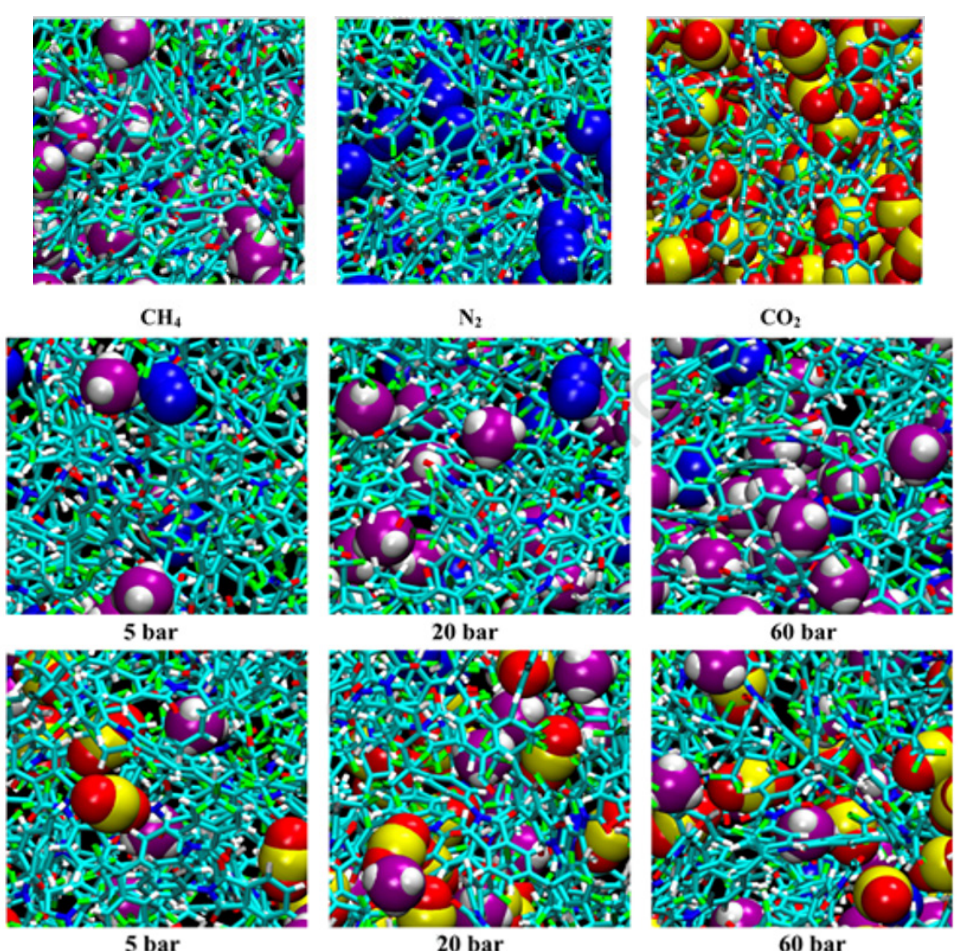
Figure 7. 6FDA-6FpDA PI with ~20 bar of methane (C = purple, H = white), nitrogen (N = blue) and carbon dioxide (C = yellow, O = red) ( top row ). 6FDA-6FpDA PI. binary 2:1 CH 4 /N 2 ( middle row ); 6FDA-6FpDA PI. ternary 16:8:1 CH 4 /N 2 /CO 2 ( bottom row ) [68].